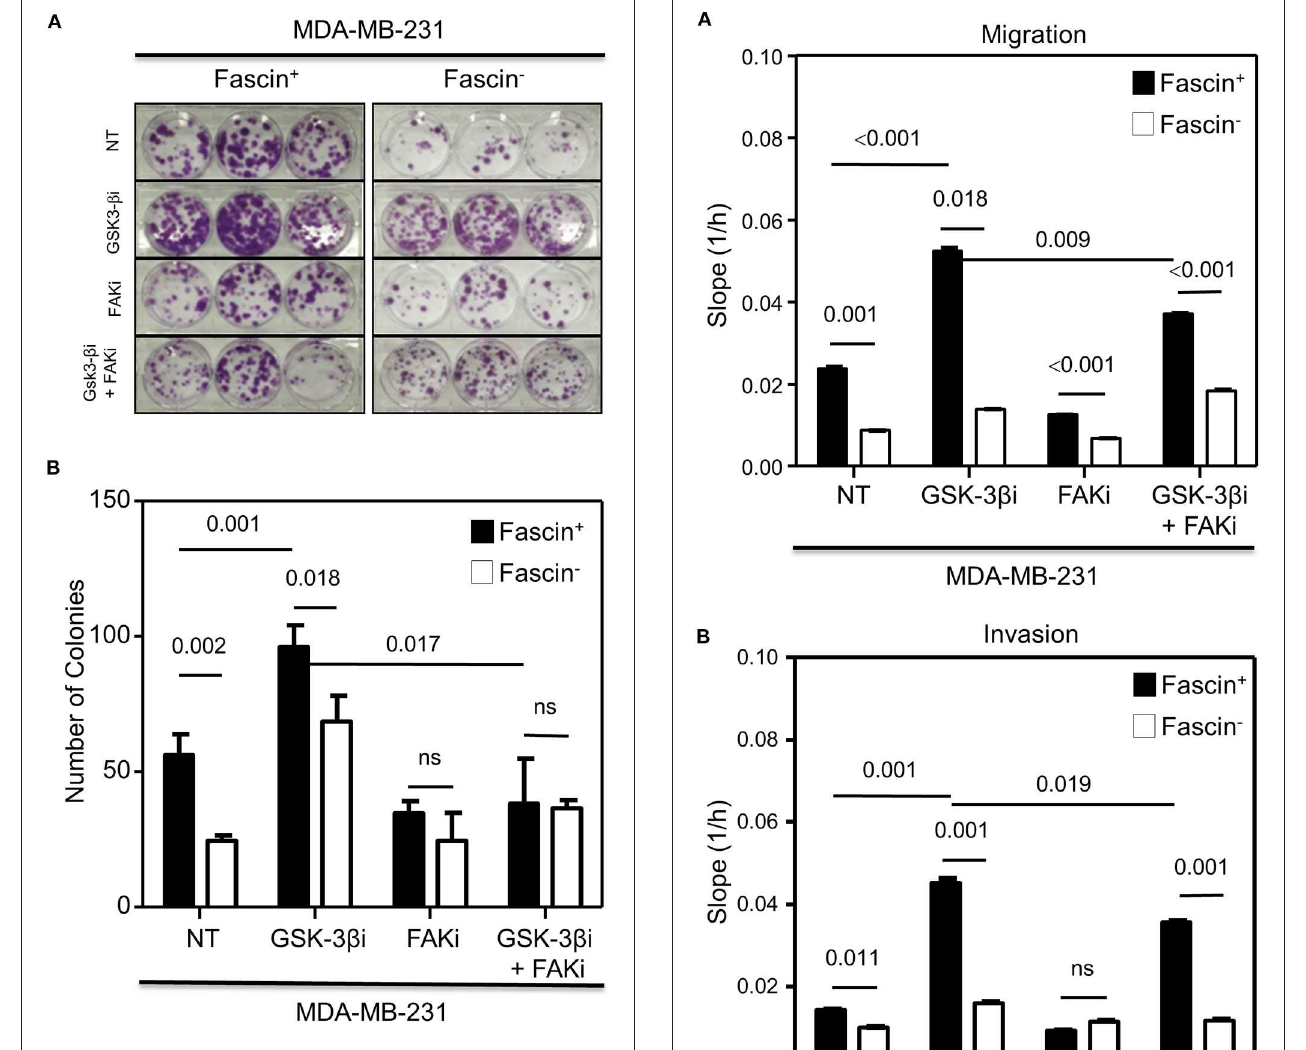
FIGURE 4 | (A,B) Fascin activation of β -catenin signaling pathway promotes colony formation in a FAK-dependent manner. (A) Representative images showing colony formation by fascin + and fascin − MDA-MB-231 cells before and after treatment with GSK-3 β i ± FAKi. (B) Bar graph showing the number (mean of triplicates ± SD) of colony formed by fascin + and fascin − MDA-MB-231 cells before and after treatment with GSK-3 β i ± FAKi. The results are representative of three independent experiments.